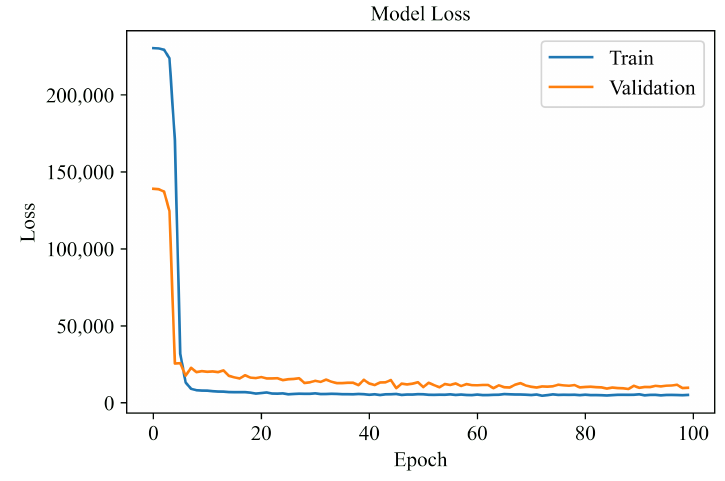
Figure 6. Loss for 252 days model.